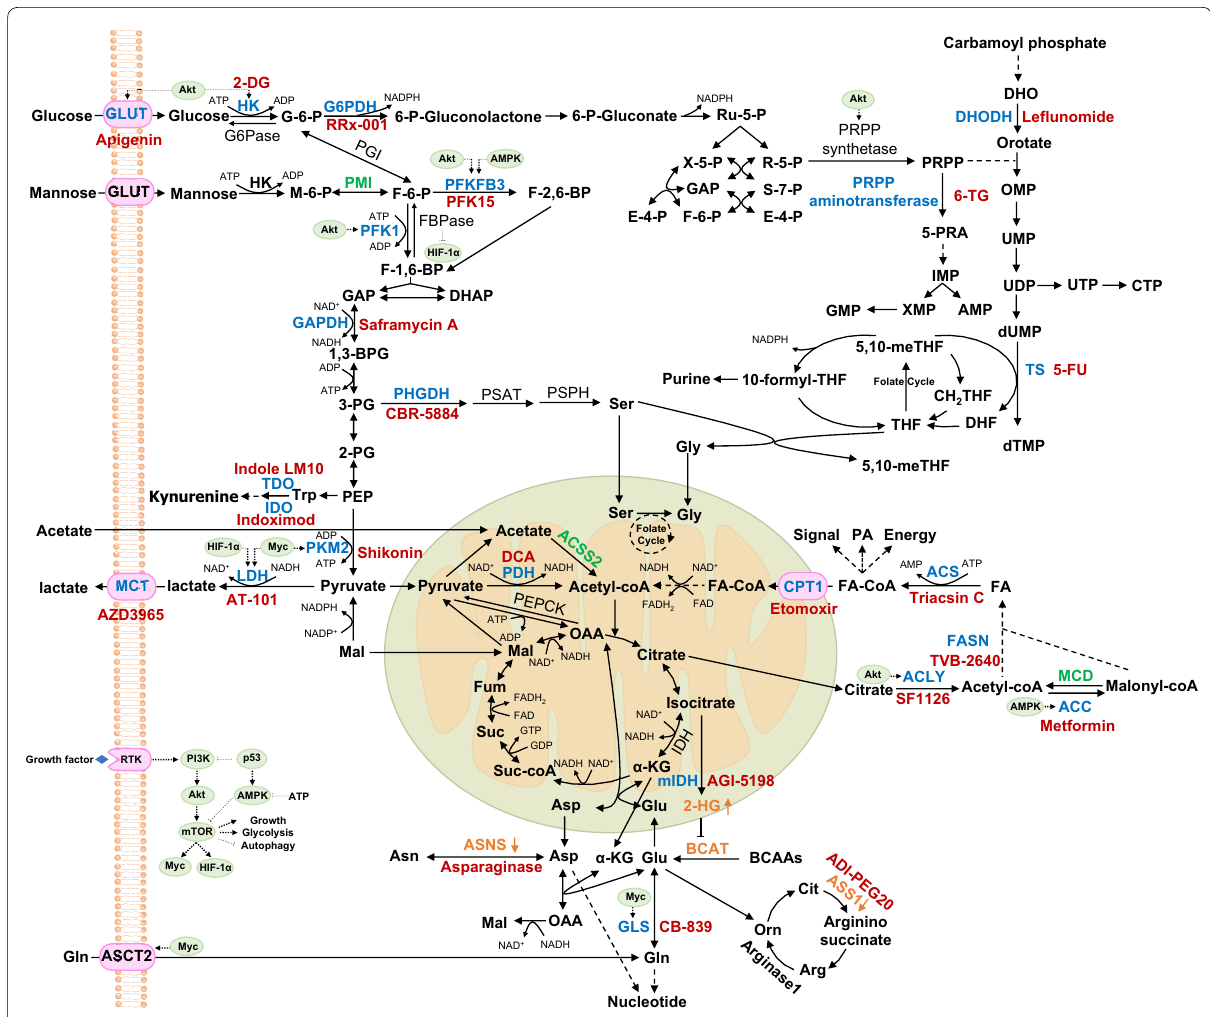
Fig. 1 Schematic diagram of targeted metabolic pathways in cancer therapy. Through the regulation of various signaling pathways, the metabolism of cancer cells changes compared with normal cells. Therefore, targeting tumor metabolic pathways is an important direction for anticancer treatment. The accumulation of mannose-6-phosphate (M-6-P) impairs further glucose metabolism. Tumor cells with low level of mannose phosphate isomerase (PMI) are sensitive to mannose, which can also become sensitive to mannose by siRNA-targeted PMI (Gonzalez et al. 2018). Glycolysis breaks down glucose into pyruvate and produces a variety of intermediates into the pentose phosphate pathway, TCA cycle, lipid metabolism, and amino acid metabolism. The pentose phosphate pathway provides reducing equivalents and precursors for nucleotide synthesis. In addition to energy metabolism, the TCA cycle also provides precursors for lipid and amino acid synthesis. Acetyl-coA is an important intermediate of energy metabolism. In human brain tumors, the contribution of acetate oxidation to the acetyl-coA pool is enhanced, and acetyl-coA synthetase 2 (ACSS2) is highly expressed, which can be a potential target for tumor detection and treatment (Mashimo et al. 2014). Acetyl-CoA carboxylase (ACC) and malonyl-CoA decarboxylase (MCD) are key enzymes in the fatty acid synthetic pathway, catalyzing the interconversion of acetyl-CoA and malonyl-CoA. At present, anticancer drugs targeting ACC have been applied in clinics, and siRNA inhibition of MCD is adverse to cancer cells, which makes MCD a potential therapeutic target (Currie et al. 2013). 2-HG, a metabolite of mIDH (mutated isocitrate dehydrogenase) tumors, has become a useful prognostic cancer marker (Salamanca-Cardona et al. 2017). 2-HG inhibits branched chain amino acid transaminases (BCATs) activity, which increases glutamate from glutamine catalyzed by glutaminase (GLS). Therefore, anticancer drugs targeting mIDH and targeting GLS can be used in combination therapy (McBrayer et al. 2018). Arginine succinic acid synthase (ASS1) and asparagine synthase (ASNS) cannot be expressed in some tumor tissues, which can also become potential targets for cancer detection and treatment (Ananieva 2015). Target metabolic enzymes (Blue); Anticancer drugs (Red); Potential targets (Green); Tumor biomarkers (Orange). Up arrow and down arrow denote the increased and decreased level of metabolites or enzymes,